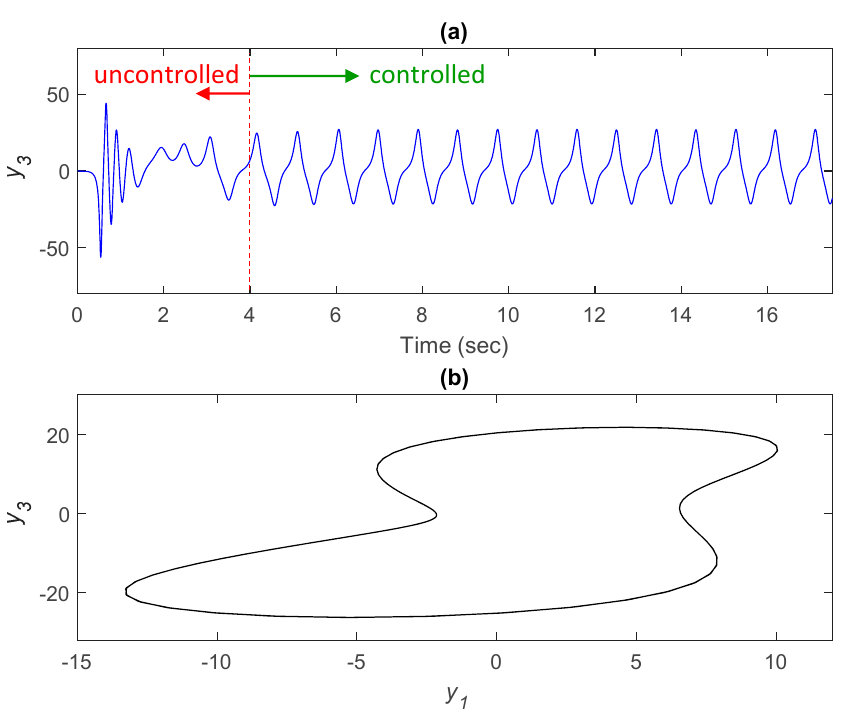
Figure 9. Bifurcation diagram of system with state-feedback control.